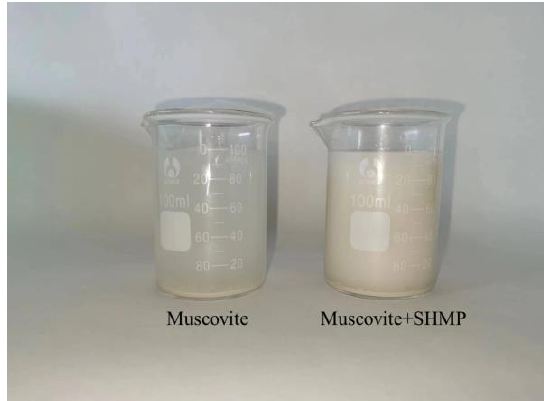
Figure 8. Effect of SHMP on the dispersion of muscovite.